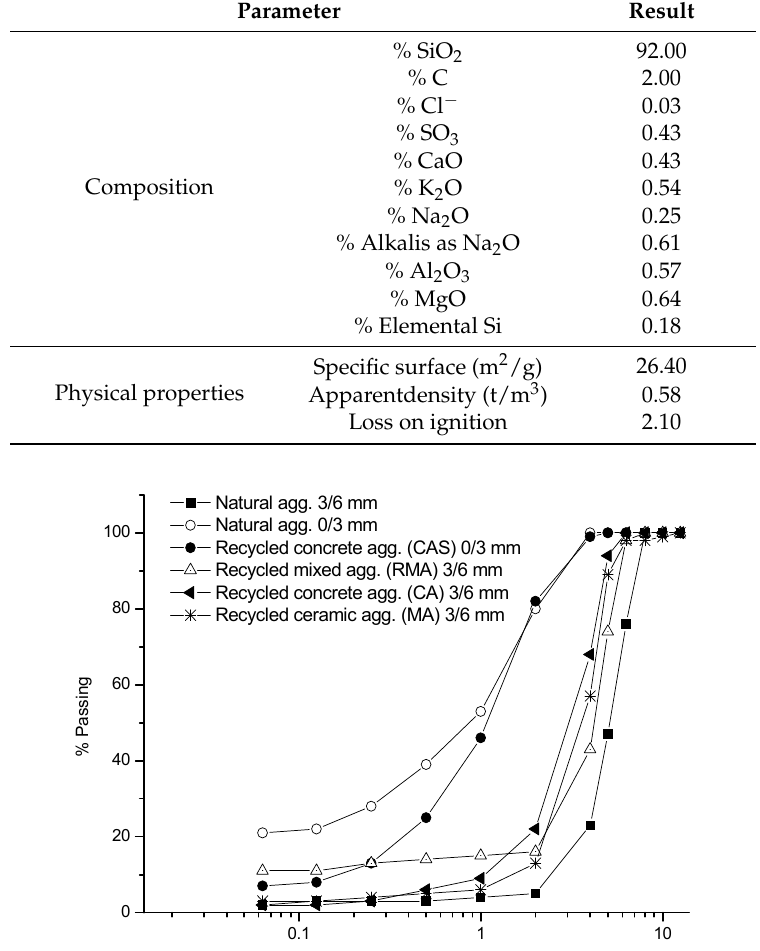
Table 2. Physical and chemical properties of silica fume.